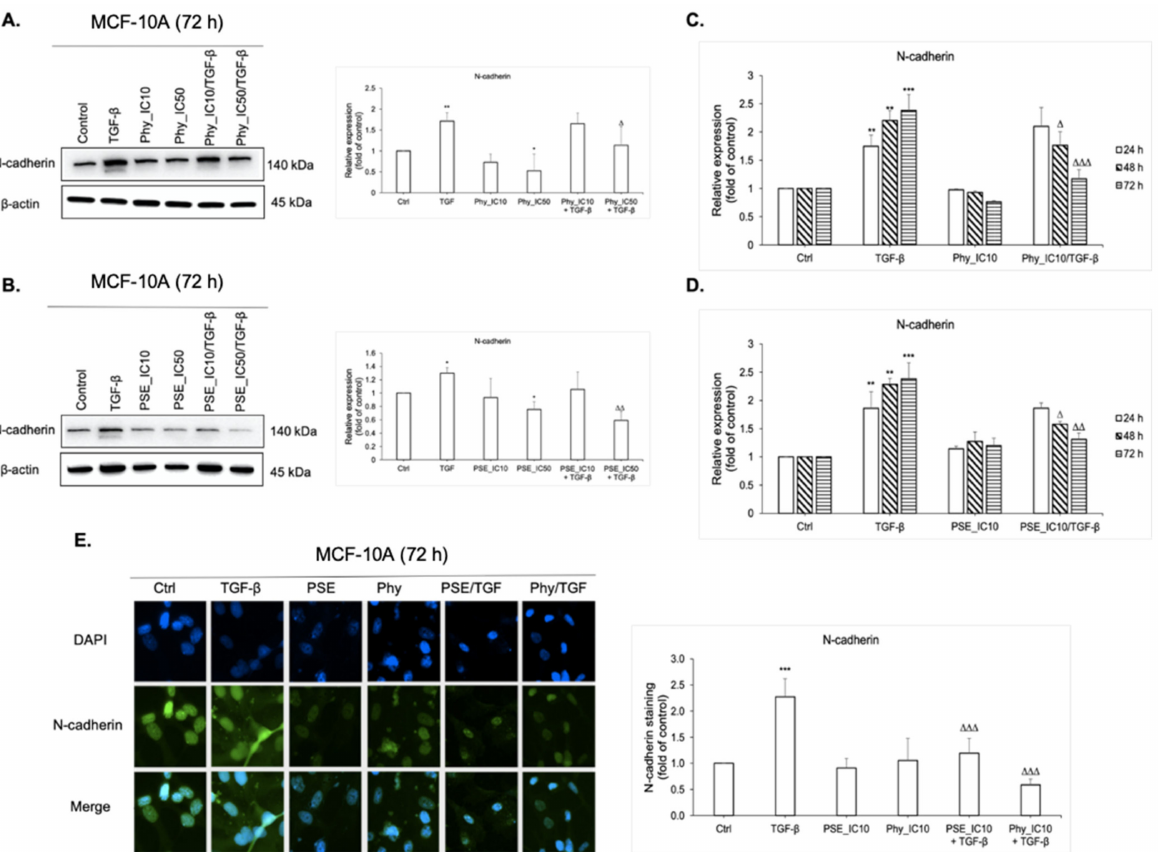
Figure 6. PSE and Phy inhibition effect on epithelial to mesenchymal transition (EMT) through decreasing N-cadherin expression in MCF-10A cells. The protein levels of EMT mesenchymal marker N-cadherin were assayed by Western blot analysis using IC 10 and IC 50 concentrations of Phy ( A ) and PSE ( B ). The band intensities of target protein were analysed using the Image Studio Lite software. Quantification is relative to the control and normalised to β -actin expression. Flow cytometry analysis of N-cadherin expression after 24, 48 and 72 h treatment with IC 10 Phy ( C ) and PSE ( D ). ( E ) Representative fluorescence microscopy images of N-cadherin expression in MCF-10A cells after IC 10 PSE and Phy treatment. The green signal represents corresponding protein staining by Alexa Fluor 488 and the blue signal indicates nuclei staining by DAPI. Original magnification x200. The fluorescence staining of N-cadherin was analysed using ImageJ software. Quantification is relative to the control. Data in graphs are shown as mean ± standard deviation (SD) for three separate experiments. * p < 0.05, ** p < 0.01, *** p < 0.001 compared to control; ∆ p < 0.05, ∆∆ p < 0.01, ∆∆∆ p < 0.001 compared to TGF- β